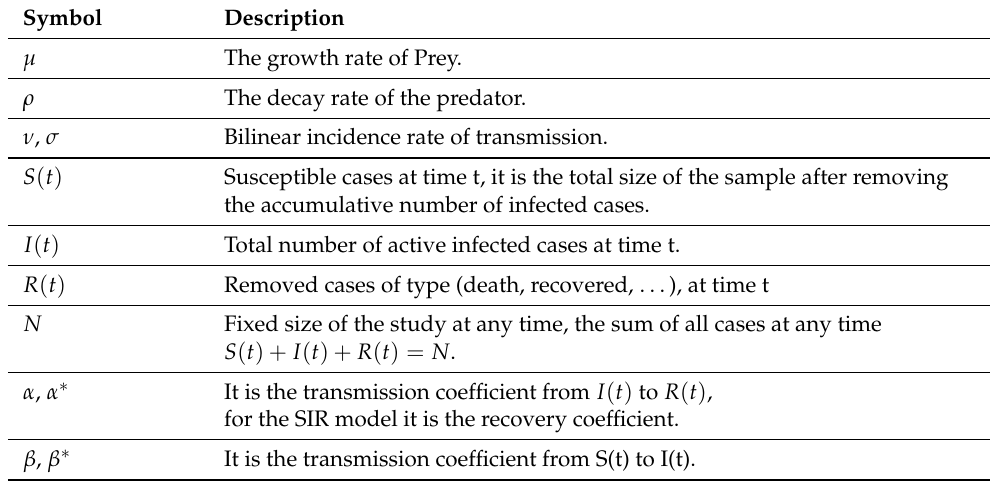
Table 2. Parameters, symbols and their description.